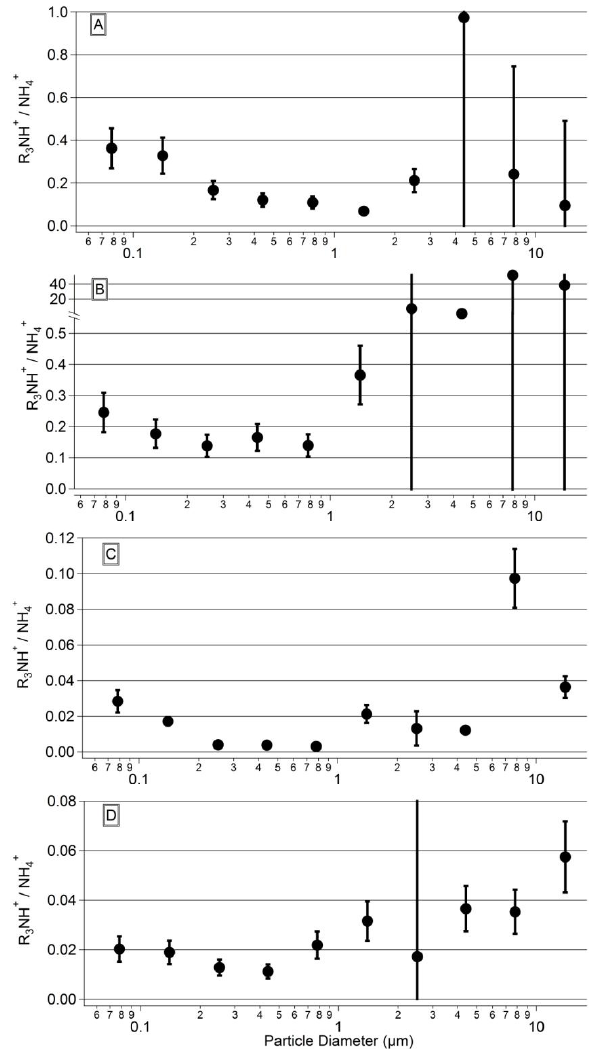
Figure 5. Ratio of the sum of all particulate amines (R 3 NH + ) measured to the total ammonium 5 Fig. 5. Ratio of the sum of all particulate amines (R 3 NH + ) mea- (moles/moles) as a function of particle diameter for (A) Sample 4 collected in Dorset, (B) 6 sured to the total ammonium (moles/moles) as a function of particle Sample 3 collected in Toronto (C) Sample 8 collected in Lambton Shores, and (D) Sample 1 7 diameter for (A) Sample 4 collected in Dorset, (B) Sample 3 col- lected in Toronto (C) Sample 8 collected in Lambton Shores, and collected in Toronto. 8 (D) Sample 1 collected in